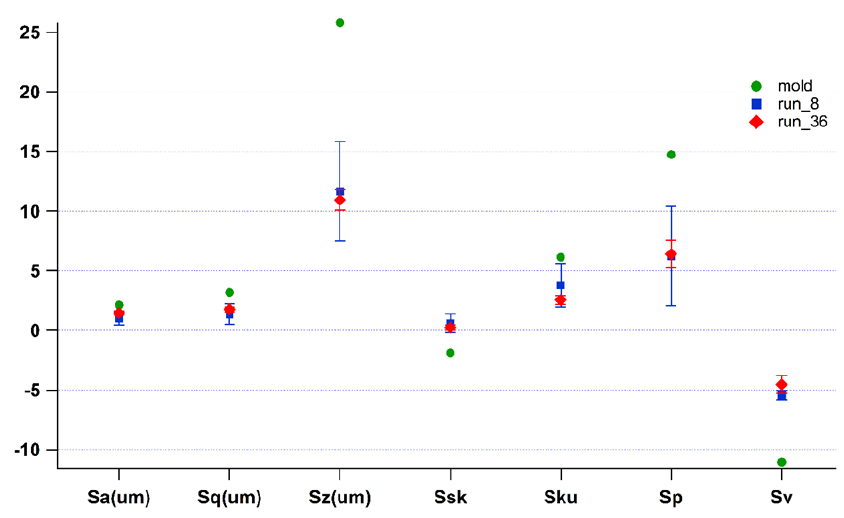
Figure 7. Surface parameters for run_8 (blue squared dots), run_36 (red rhombic dots), and mold (green dots).